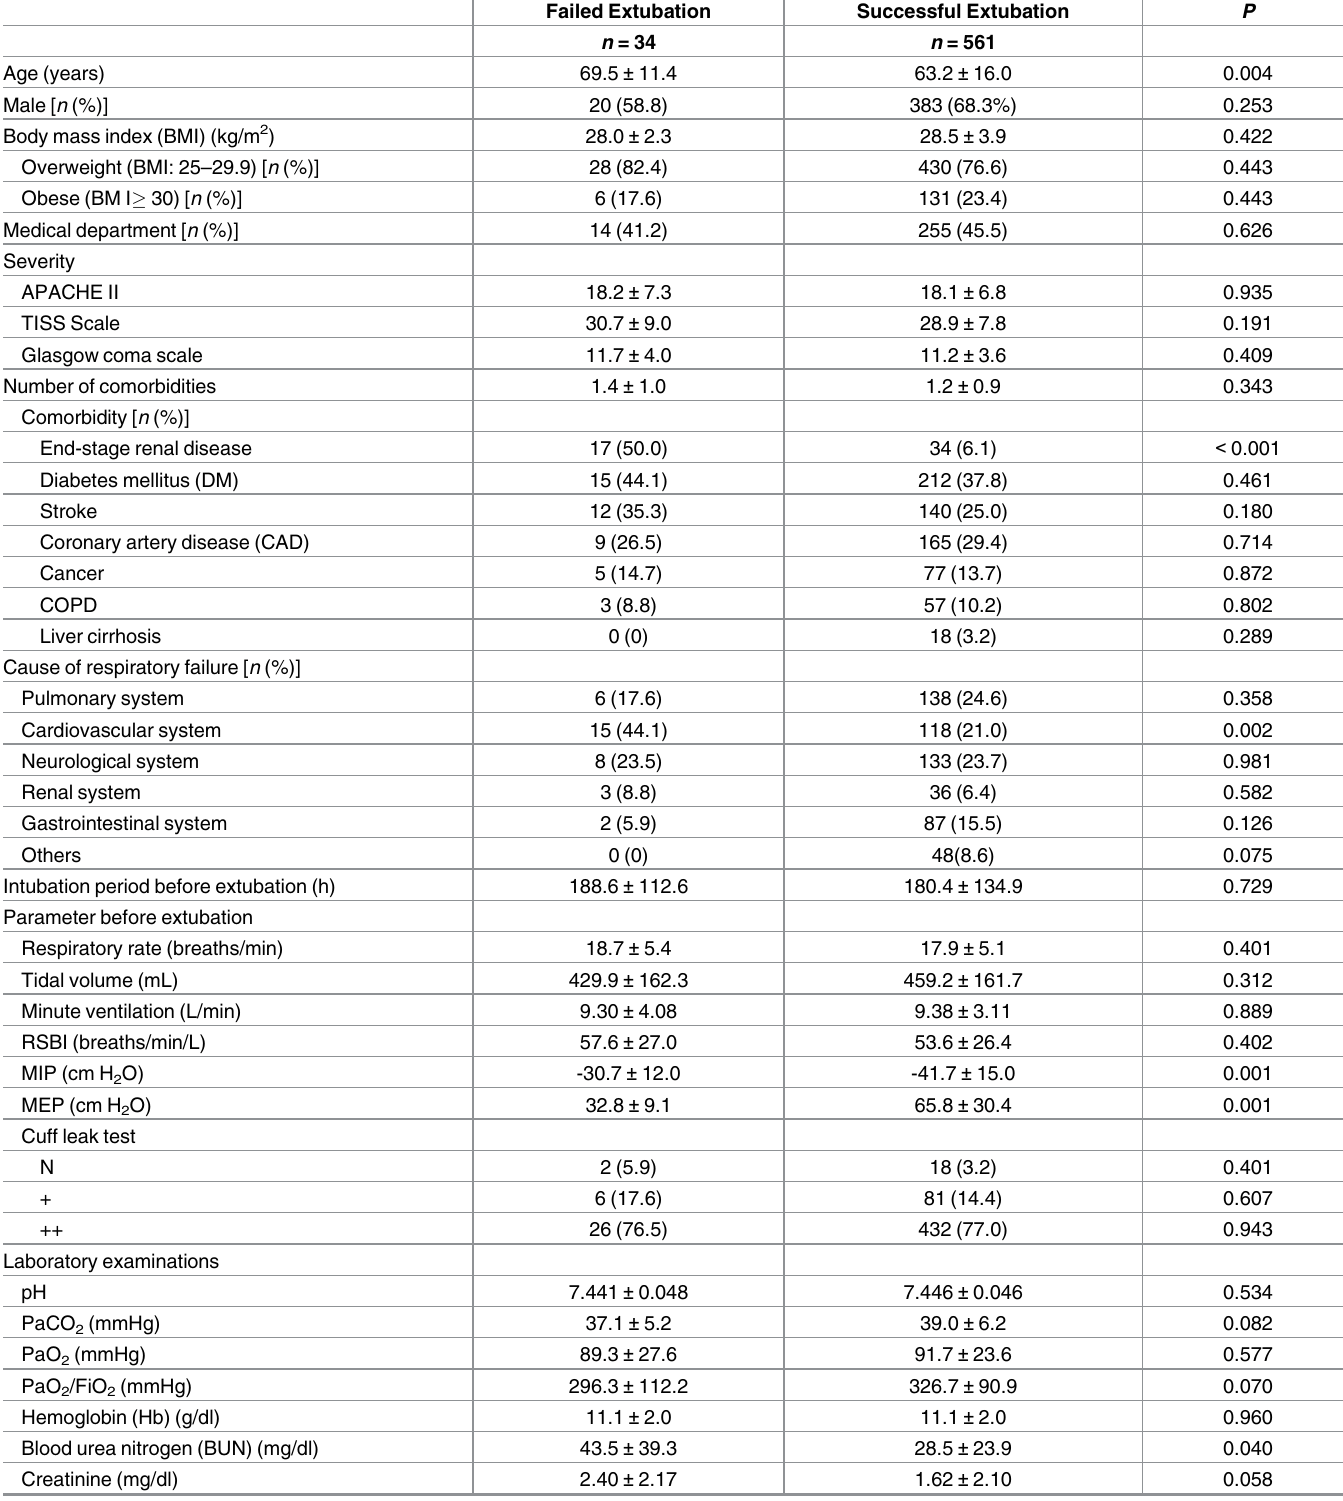
Table 2. Comparison of Failed and Successful Extubation